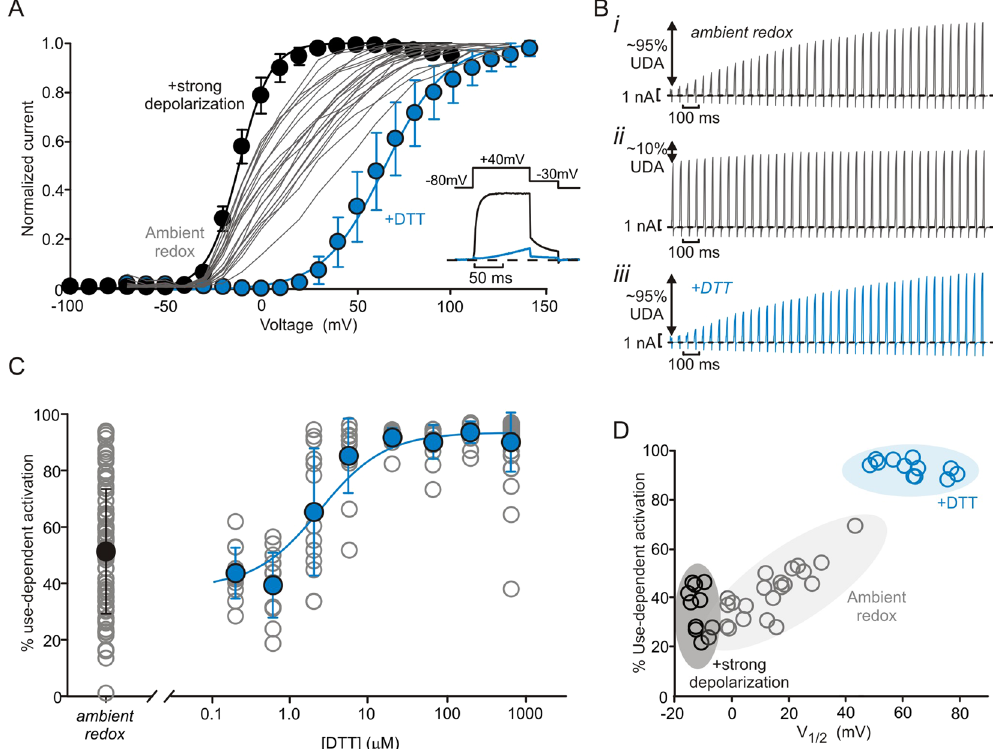
Figure 1. Reducing conditions promote use-dependent activation. Conductance-voltage relationships were recorded from tail current amplitudes at − 30 mV (see inset) in ltk- fibroblast cells expressing Kv1.2. Grey lines are conductance-voltage relationships from multiple individual cells in ambient redox conditions (spread of V 1/2 is from − 1.7 to + 43 mV). Mean conductance-voltage relationships ( ± S.D.) are shown for cells incubated in 666 µ M DTT (N = 13, blue symbols, V 1/2 = + 64 ± 11 mV), or collected with a modified protocol that delivers a 500 ms depolarization to + 60 mV before each voltage sweep (black symbols, N = 11, V 1/2 = − 11 ± 3 mV). (Inset) Currents elicited with a + 40 mV depolarization illustrate the suppression of current in DTT. ( B , i – iii ) Kv1.2 expressing cells were stimulated with repetitive 10 ms depolarizations from a holding potential of − 80 mV to + 60 mV (20 Hz frequency). Different sample sweeps reflect the variability of use-dependence in ambient redox (i,ii), and a shift towards strong use-dependence after incubation in DTT (iii). ( C ) % use-dependent activation (UDA) is calculated as the fraction of activating current during the pulse train: (pulse 100 peak current – pulse 1 peak current)/(pulse 100 peak current), (blue symbols: mean ± S.D., grey symbols: data for individual cells in each condition; N = 87 for ambient redox, N = 44 for 666 µ M DTT, and N = 12–14 for other DTT concentrations). DTT dependence of average UDA was fit with a Hill equation (EC50 = 1.6 µ M and a Hill coefficient of 1.0). ( D ) Cell-by-cell correlation between % use-dependent activation and V 1/2 measured in ambient redox (gray, N = 21), DTT (blue, N = 13), or after potentiation by strong prepulses (black, N =